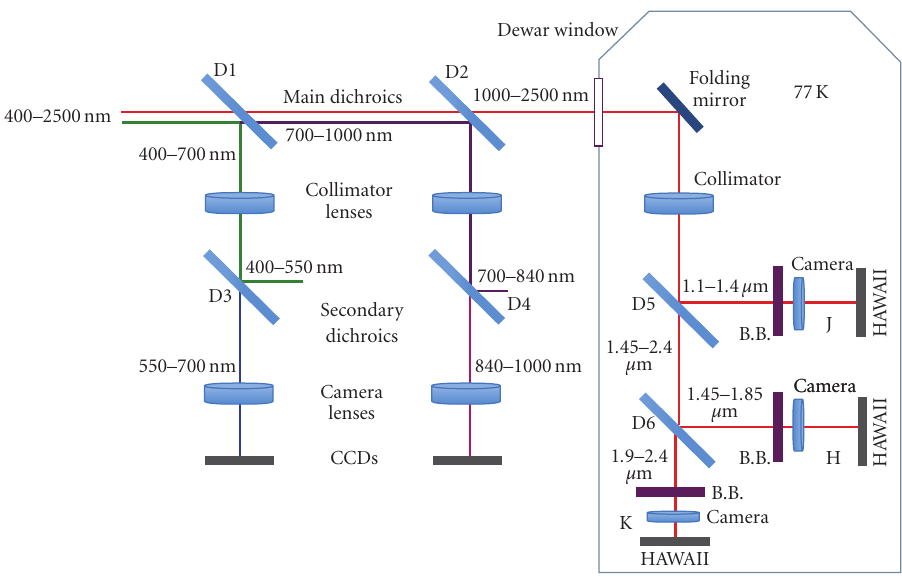
Figure 8: The dichroics cascade, feeding the VIS and NIr